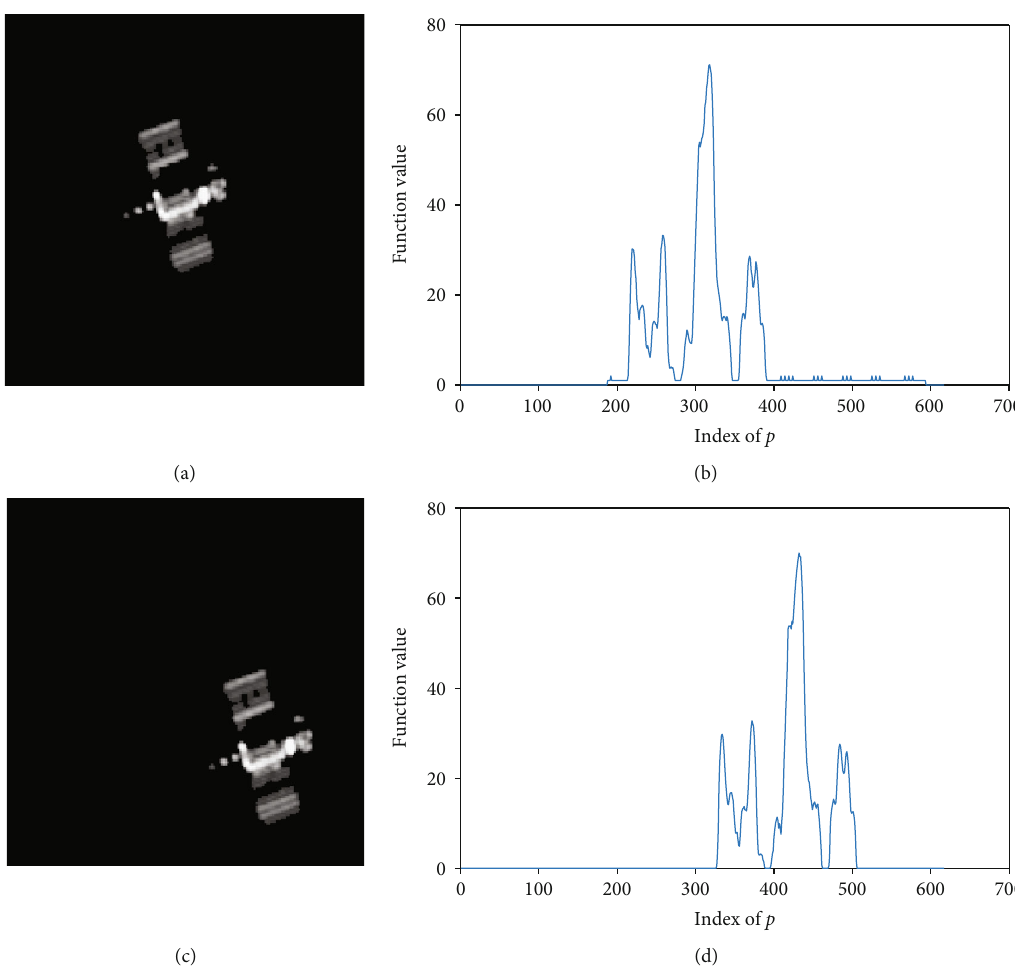
Figure 5: Trace features corresponding to the ISAR image before and after translation.